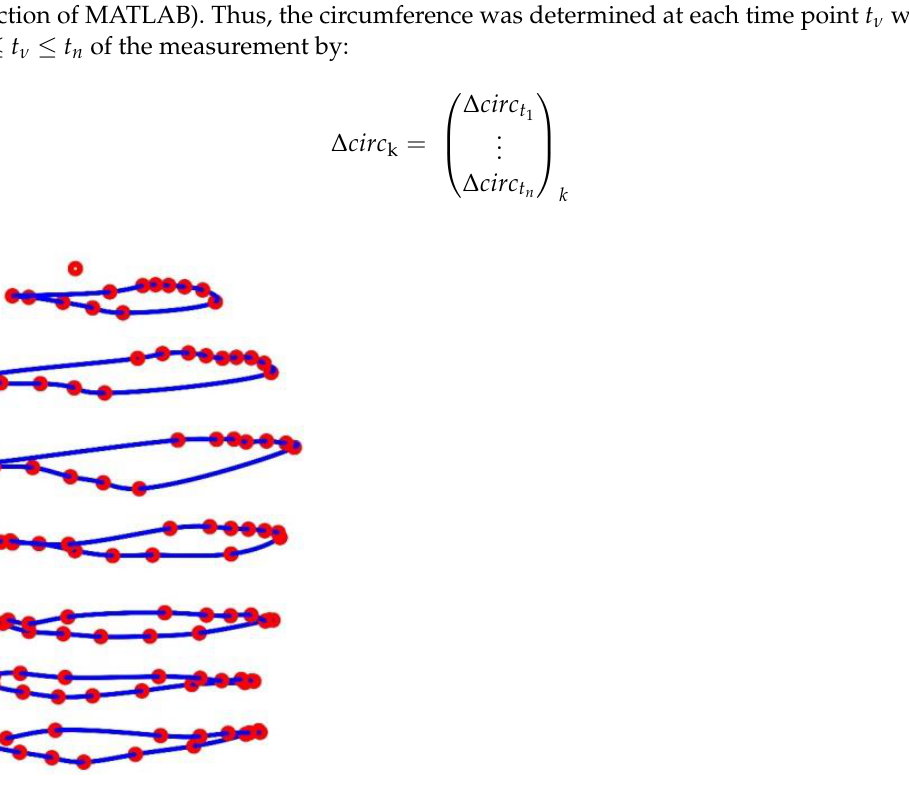
Figure 6. Illustration of the circumferences in 7 different heights at the upper body obtained via closed spline curves (blue) through the MoCap markers (red). The MoCap marker at the top is the reference marker.